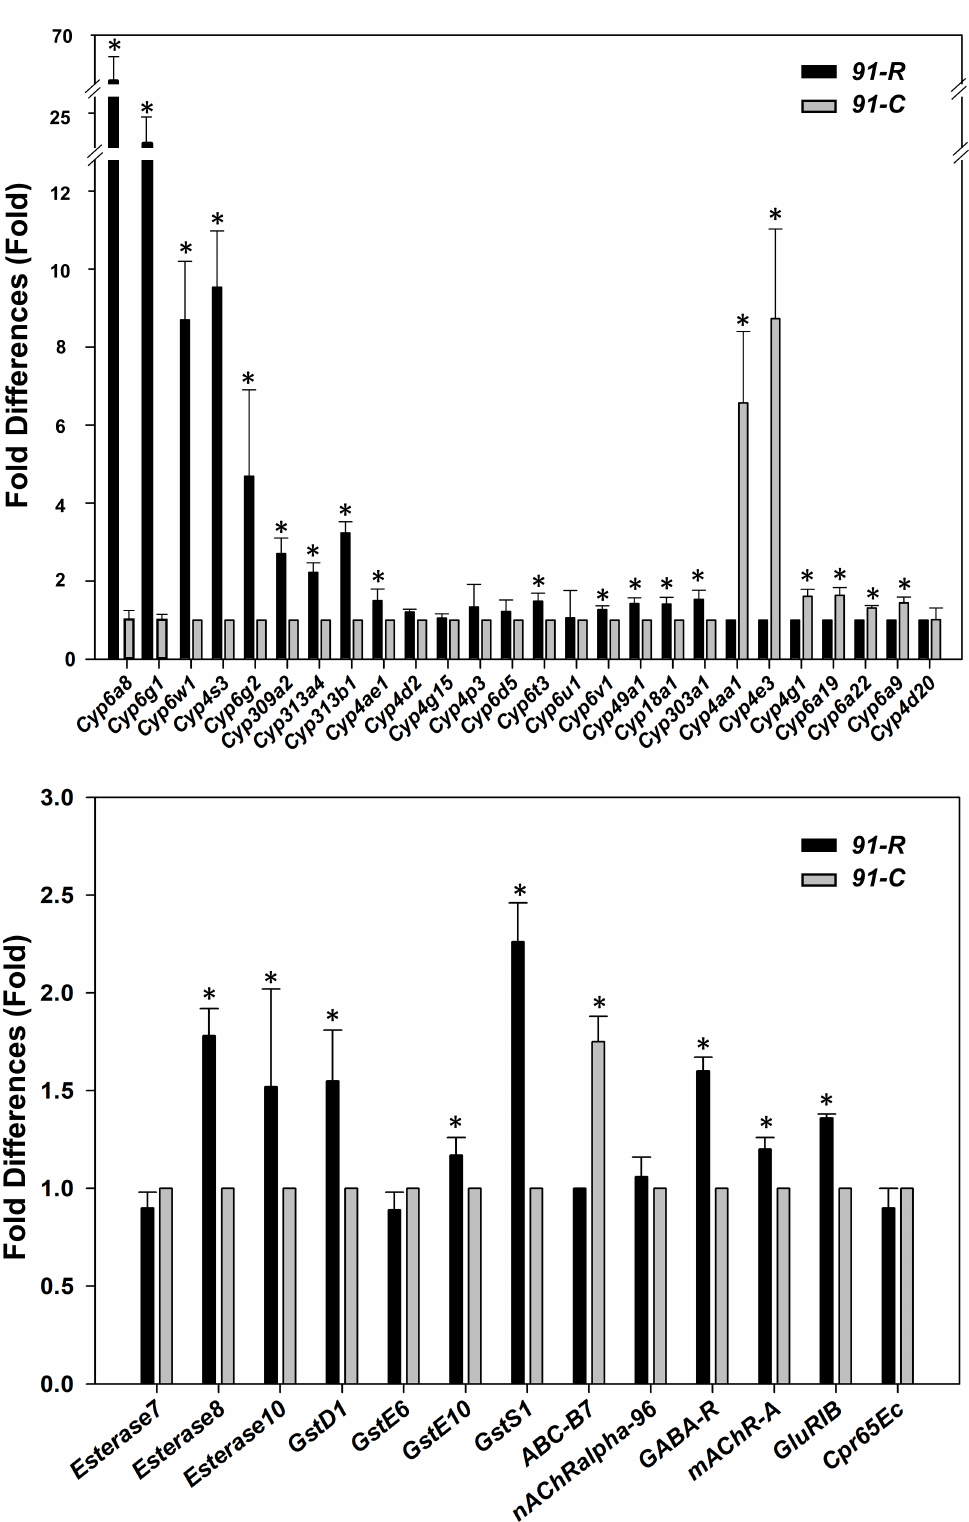
Fig 4. Expression level analysis of potential target detoxification genes of differentially expressed miRNAs between 91-R and 91-C strains. The expression levels were normalized by rp49 .Statistical significance was analyzed using one-way ANOVA. The asterisks represent significance, with a single asterisk indicating P < 0.05.